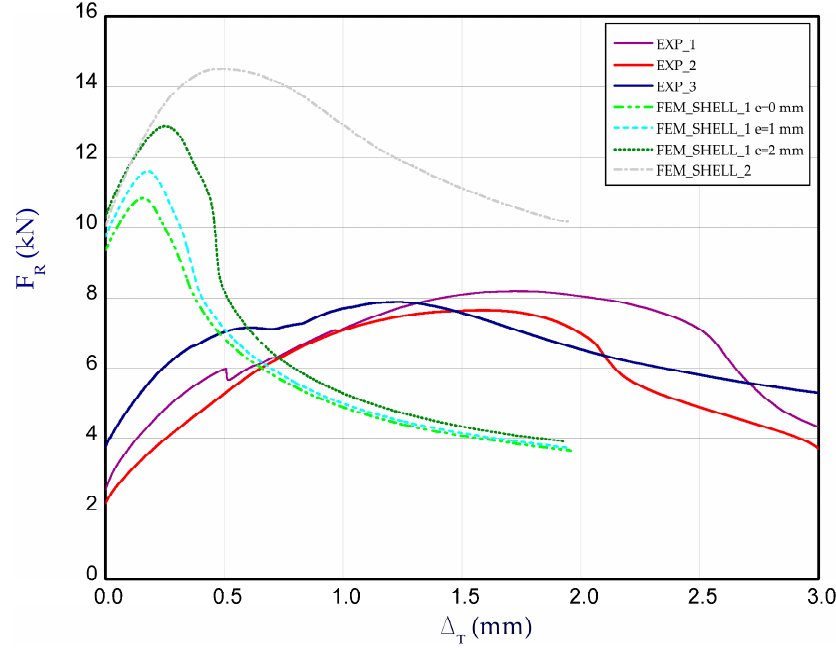
Figure 18. The compression curves of column at 125 °C.